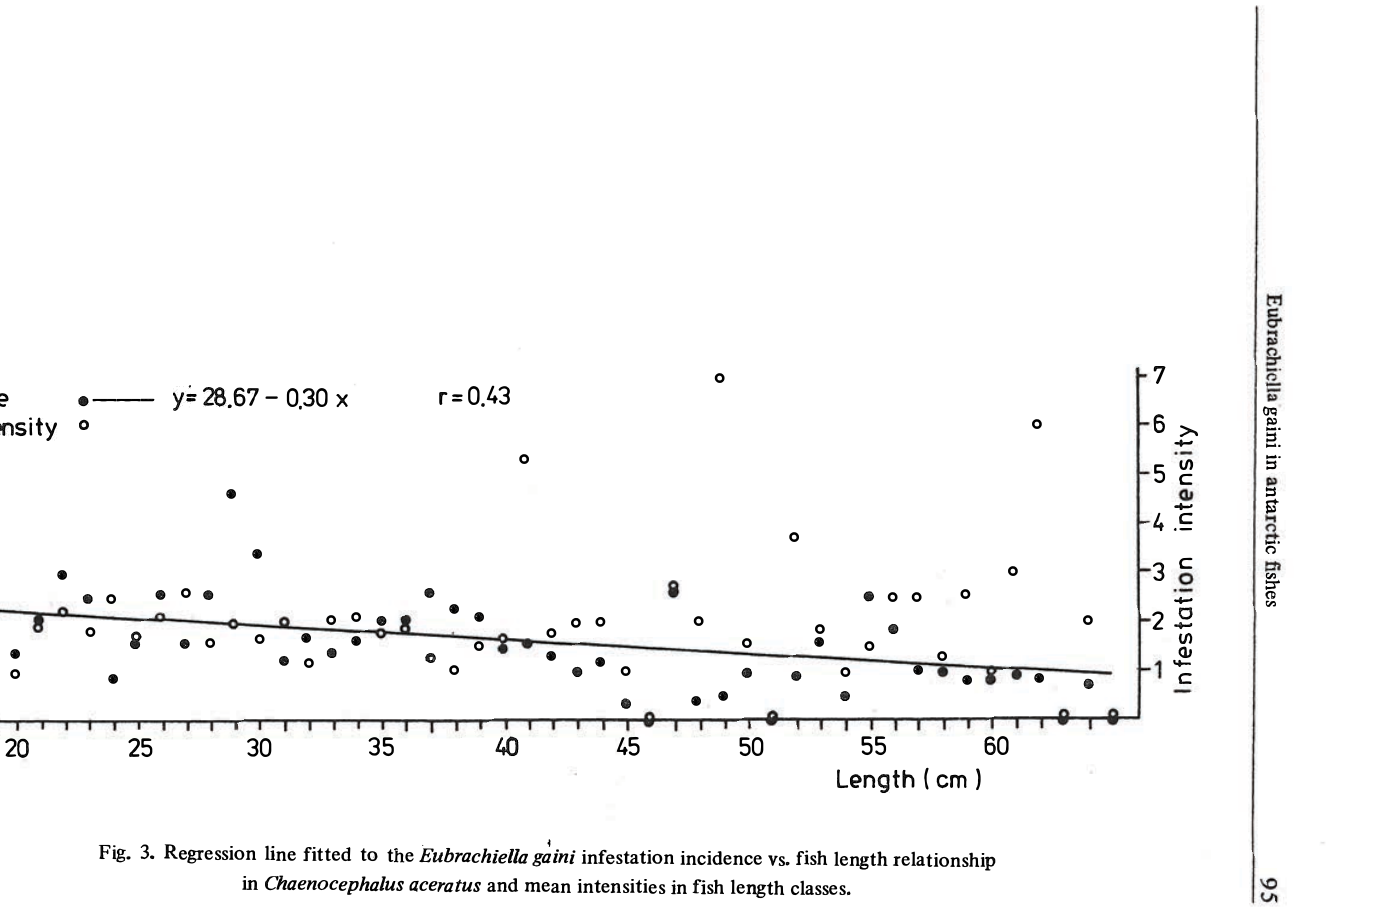
3. Regression line fitted to the Eubrachiella gaini infestation incidence vs. fish length relationship in Chaenocephalus aceratus and mean intensities in fish length